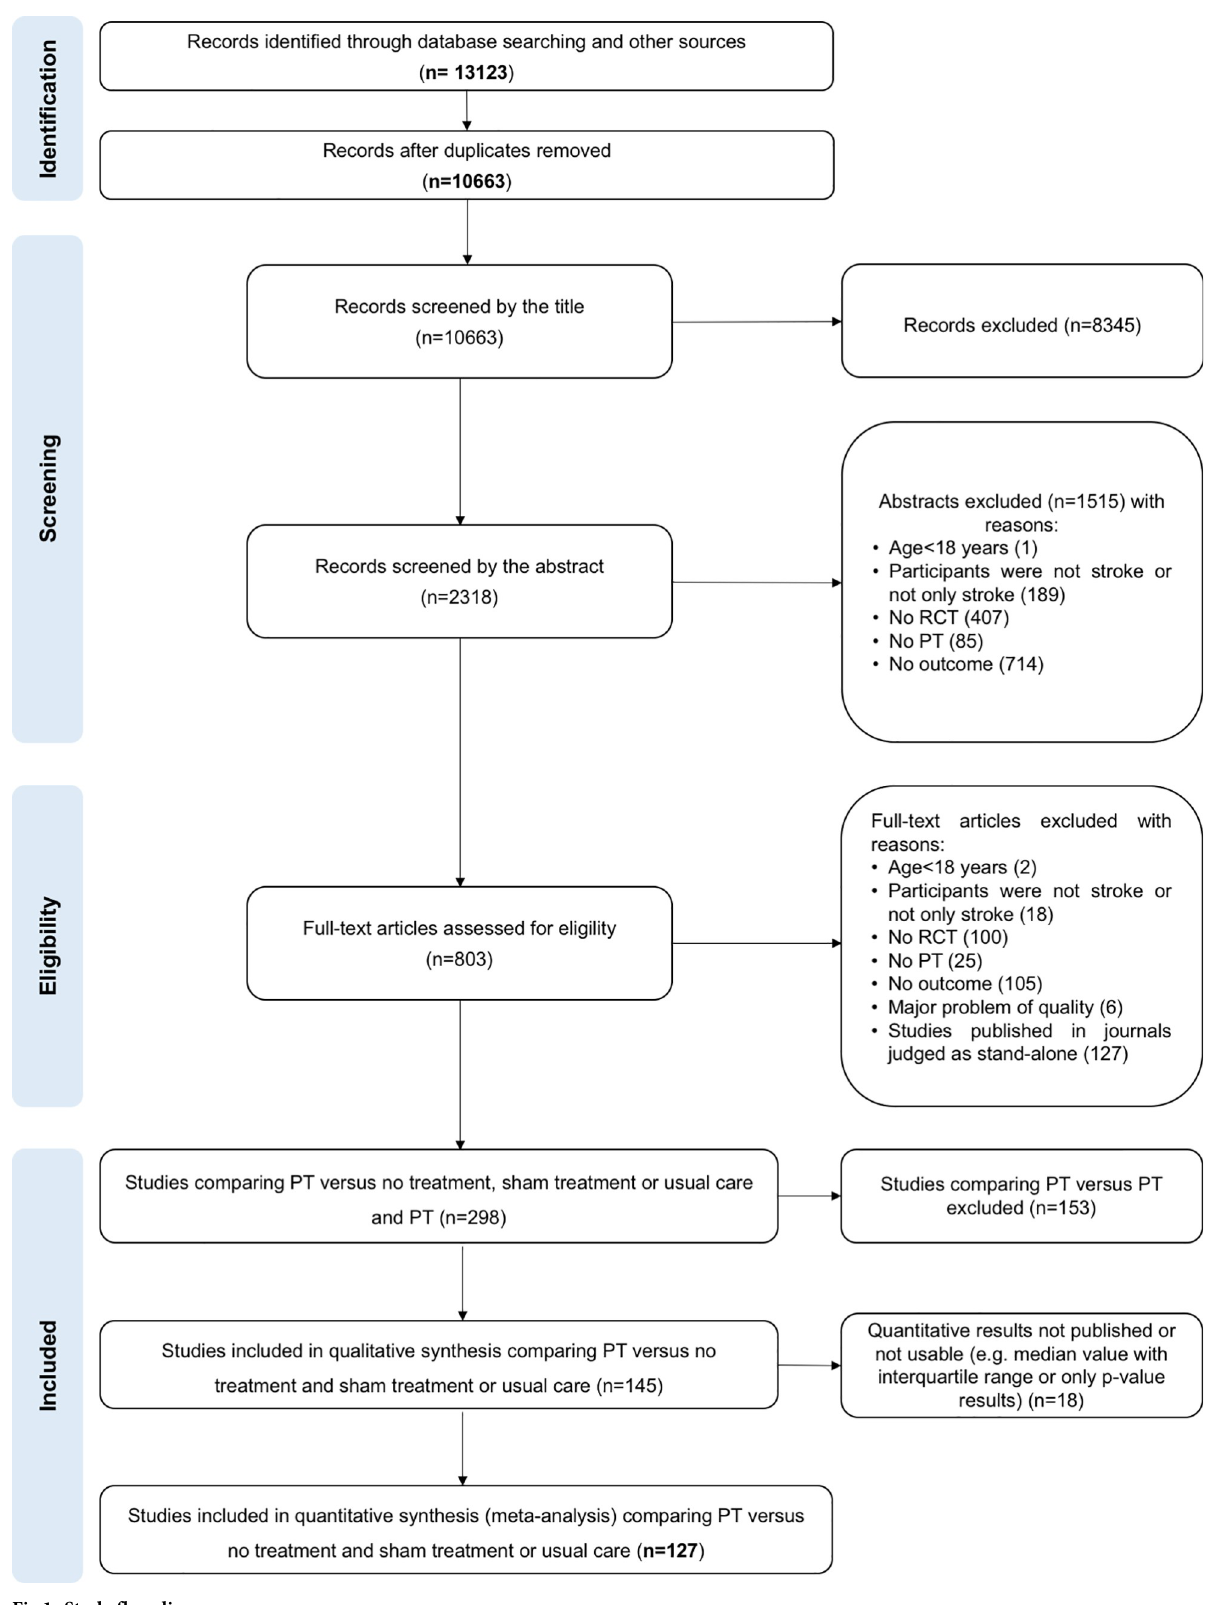
Fig 1. Study flow